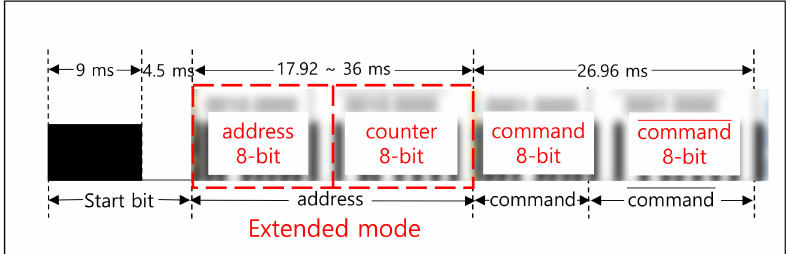
Figure 17. The ‘8-bit counter’ transmission using extended mode in NEC protocol.